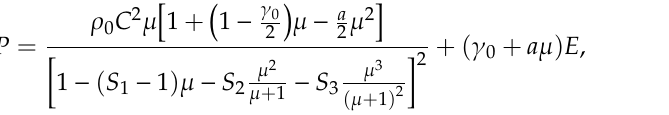
Table 4. Material parameters of nitrogen and liquid